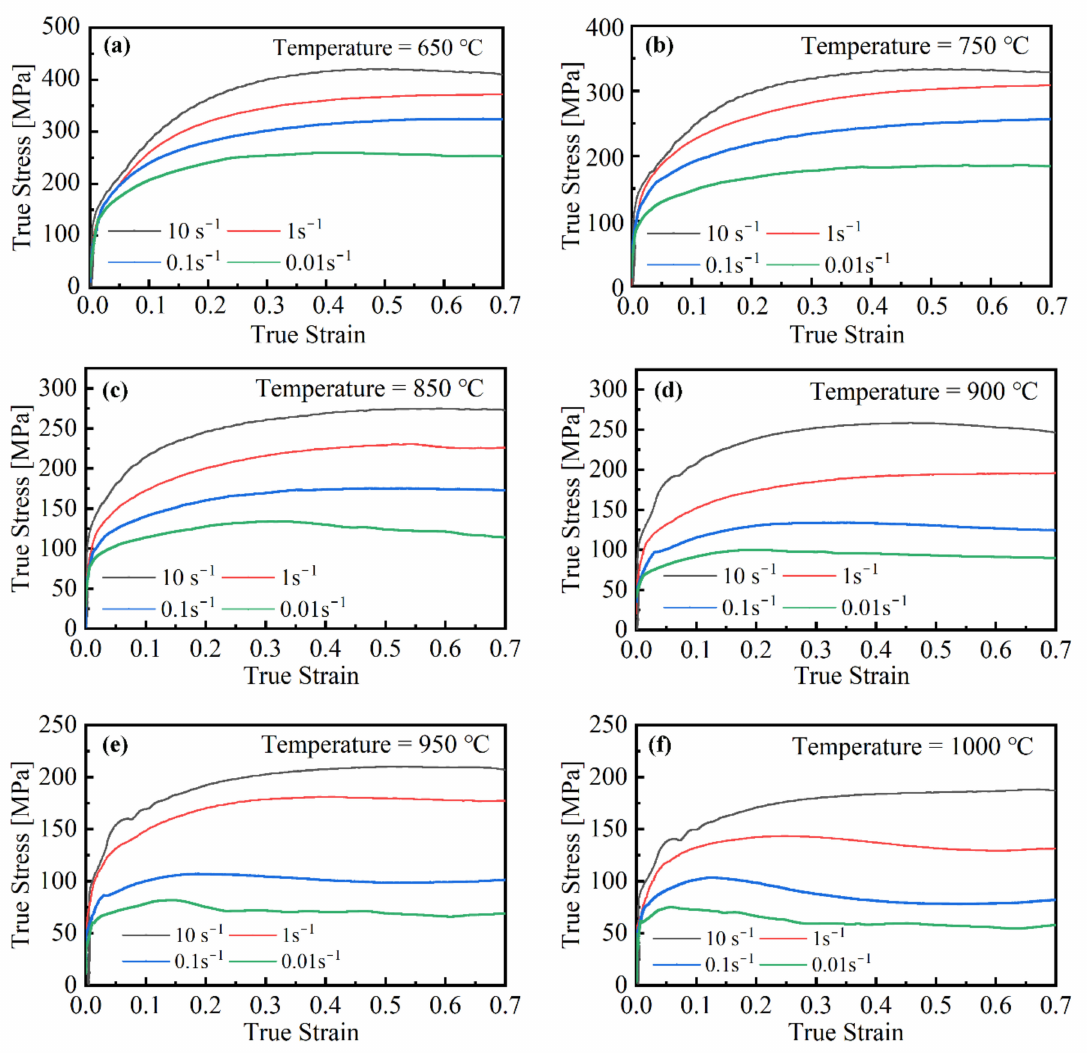
Figure 5. The true stress–strain curves of B1500HS steel under the different deformation conditions: ( a ) 650 ◦ C; ( b ) 750 ◦ C; ( c ) 850 ◦ C; ( d ) 900 ◦ C; ( e ) 950 ◦ C; ( f ) 1000 ◦